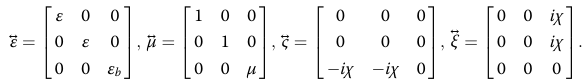
of in-plane nodal chain, where the nodal lines are chained together in a single plane. In-plane chain points are usually fragile against perturbations, but the chain point in our system is protected by the electromagnetic intrinsic symmetry at the Γ point unless a cut-off frequency is